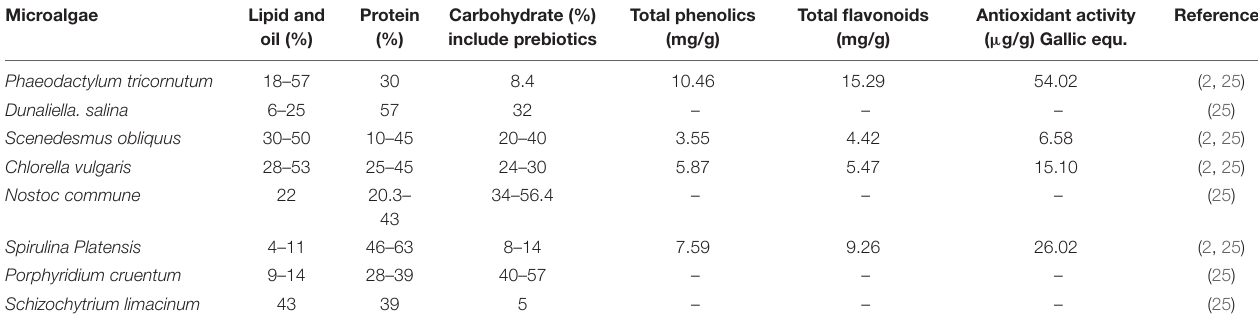
TABLE 1 | Oil, protein, and carbohydrate contents of marine microalgae expressed on a dry biomass. Microalgae Lipid and